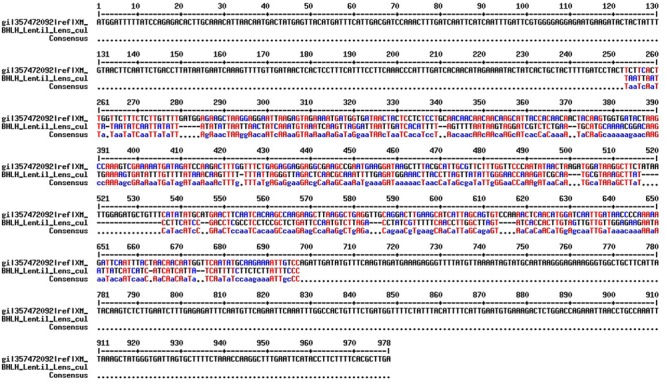
Sequence alignment between M. truncatula BHLH full length CDS (NCBI reference number XM_003606283.1) and lentil BHLH-1 partial genomic sequence using the MultAlin (Corpet, 1988) with default parameter values. The overlapping potential exonic region (72 bp) is marked in blue and red color.